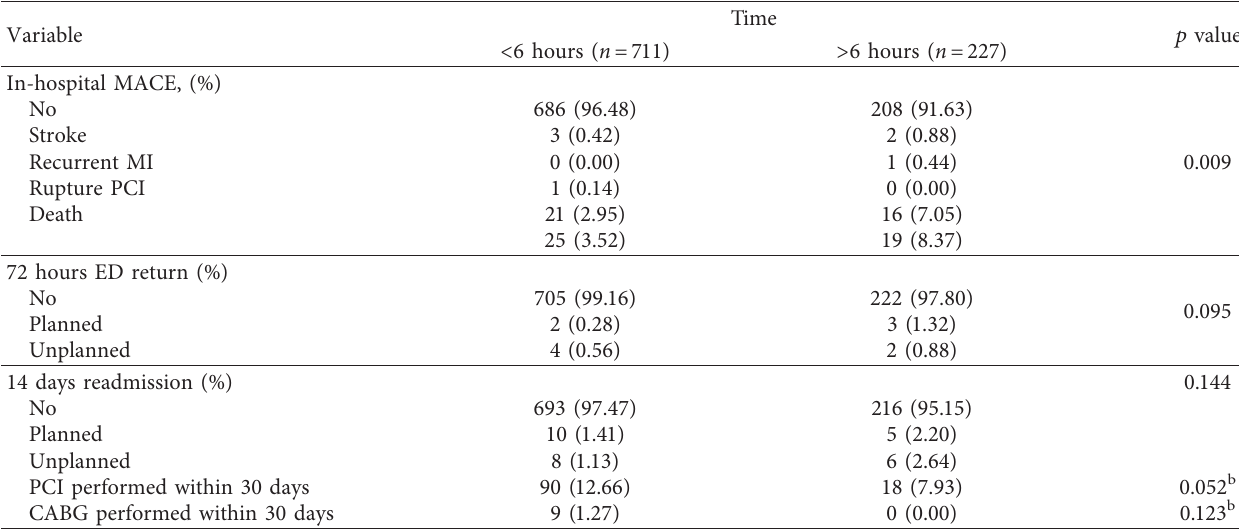
Table 2: Patient outcome in each group.